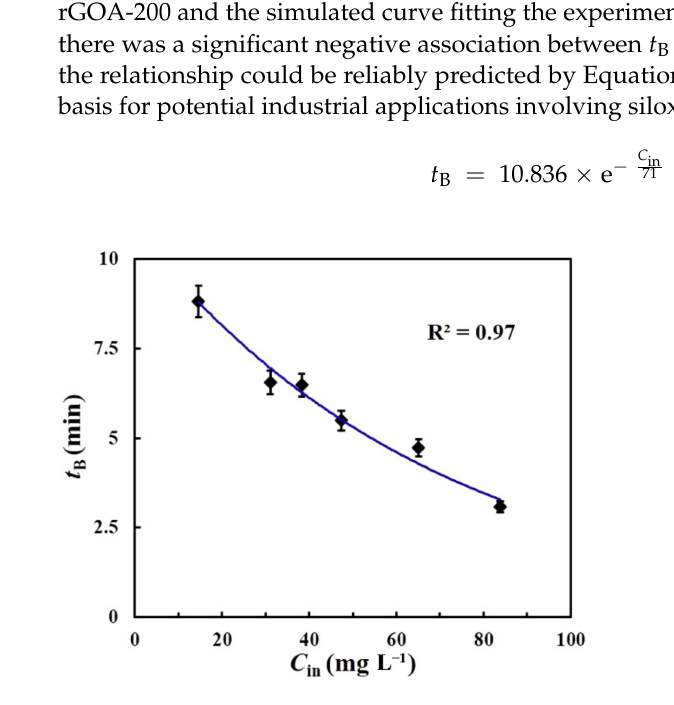
Figure 10. The effect of inlet concentration on breakthrough time.